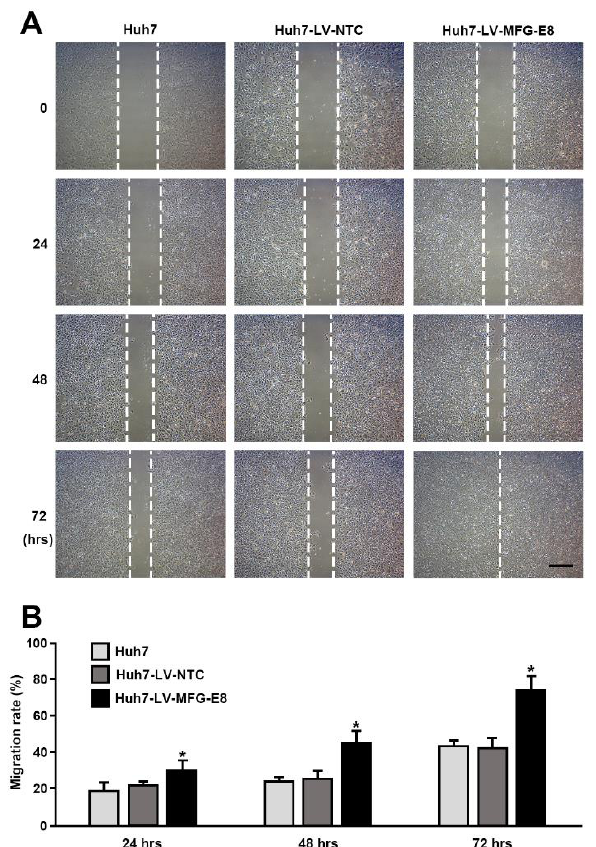
Figure 4. Effects of MFG-E8 overexpression on HCC cells migration. ( A ) Migration of Huh7 cells transfected with either nontargeting control lentivirus vector (LV-NTC) or LV-MFG-E8 was evaluated by a scratch assay; phase-contrast images were taken 24, 48, 72, and 96 h after making the mechanical scratch wound in vitro. The migration rates are shown in ( B ). Data represent the mean ± S.D. * p < 0.05, a two-tailed Student’s t -test. Scale bars, 200 μm .